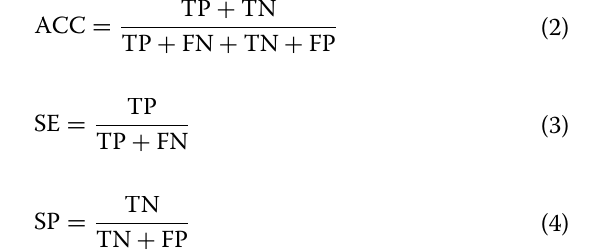
represents the final benign and malignant probabilities of the j -th image of the i -th sequence, where , p D j i represents the probability from the tumor detection model with the j -th image of the i -th sequence of the p patient, M i represents the probability from the sequence classification model with the i -th sequence of the patient, and A p represents the probability based on the patient’s (cid:31) (cid:31) (cid:31) 1 , 2 , 3 are the weights of the three terms. age. The benign and malignant tumor categories of all images in each sequence were obtained by using Eq. (1), and the category with the largest proportion was selected as the sequence category. Finally, the category with the largest proportion of all sequences was selected as the benign or malignant category for this patient.